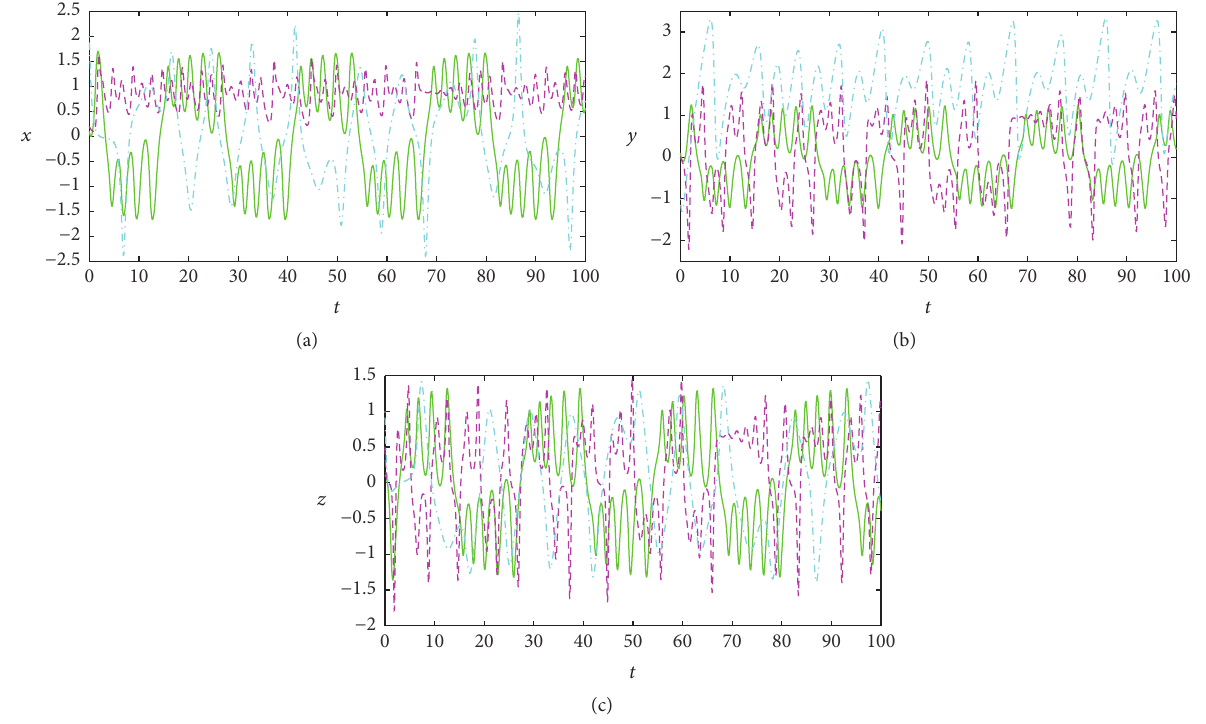
Figure 1: Time series of the three selected systems: (a) 𝑥 time series, (b) 𝑦 time series, and (c) 𝑧 time series.